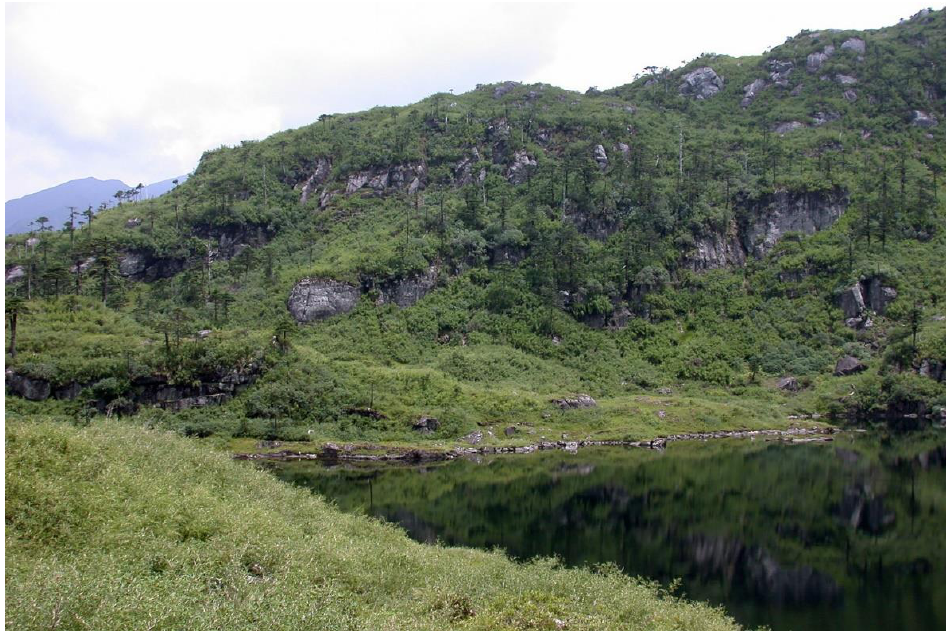
Figure 4. Collecting locality of Marsupella praetermissa Bakalin et Vilnet sp. nov. (Photo by D. Long, 2006).